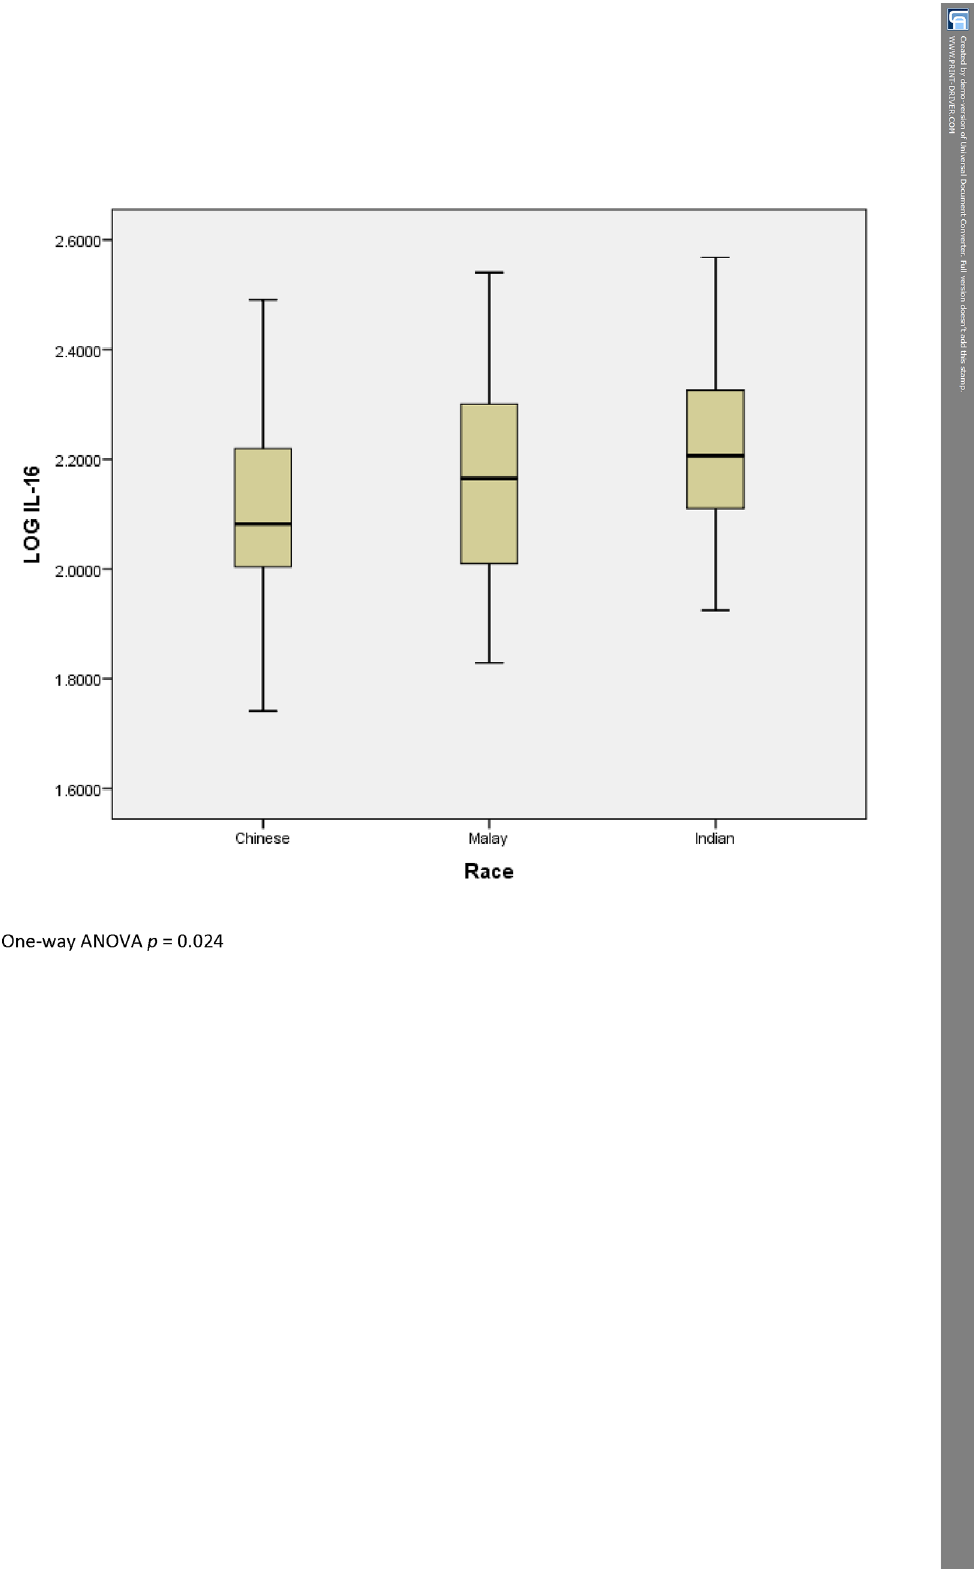
Fig 2. Boxplot of serum IL-16 levels between the different races. https://doi.org/10.1371/journal.pone.0184802.g002 PLOS ONE | https://doi.org/10.1371/journal.pone.0184802 September 14,